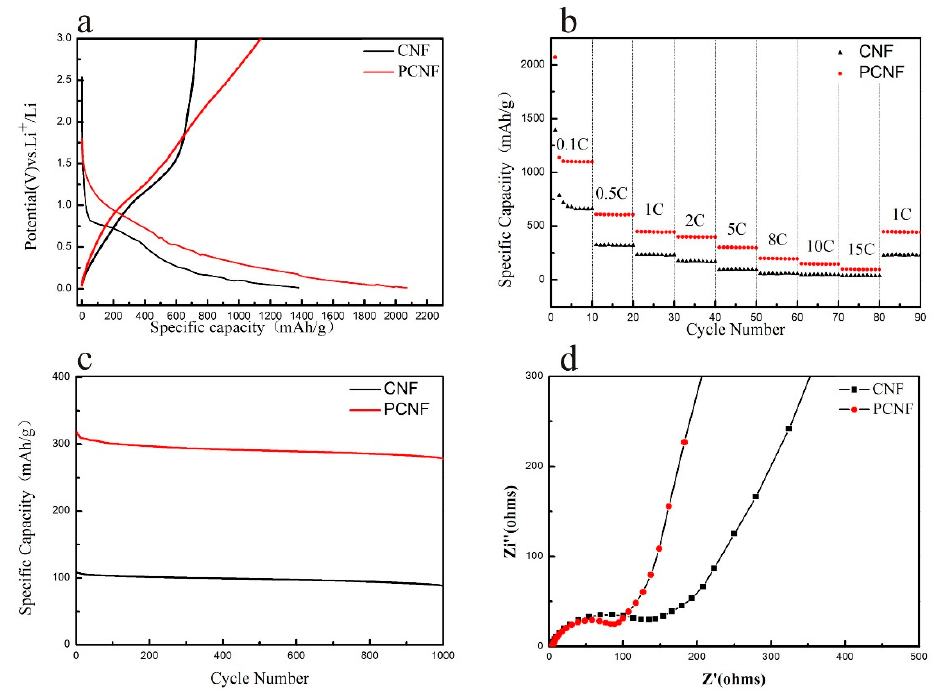
Figure 5. Electrochemical measurements of CNF and PCNF samples. ( a ) First discharge-charge images at 0.1 C; ( b ) rate capability; ( c ) Long cycling capability at 5 C; ( d ) electrochemical impedance spectra.